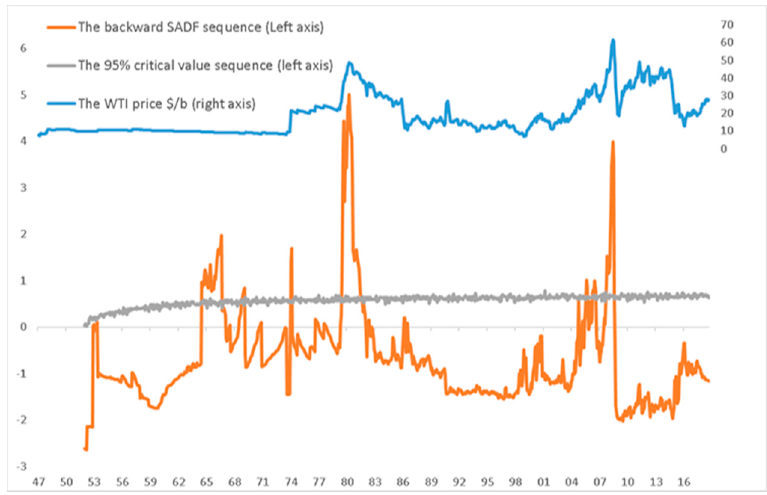
Figure 3. Date-Stamping Explosive periods in the West Texas Intermediate (WTI) prices: the GSADF Test, Author’s calculations.